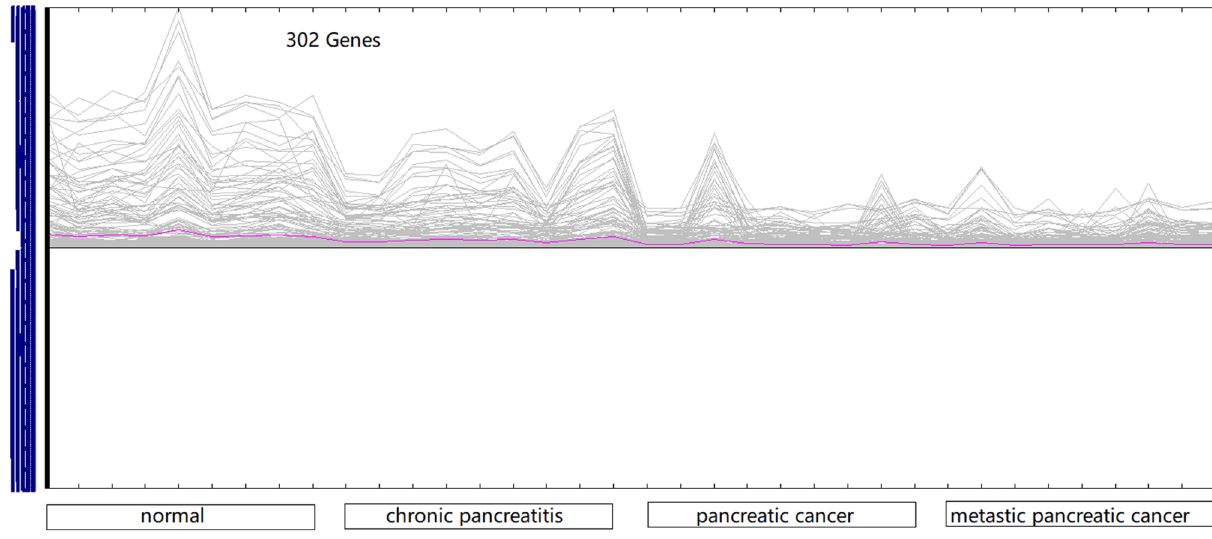
Figure 2. The expression graph of significant DEGs by Table S4); the metastatic pancreatic cancer DEGs were enriched in immune response, metabolism, energy path- way, protein metabolism and cell growth and maintenance (Fig. 3, Table S5). The SAM DEGs were enriched in lymphocyte activation, lymphocyte proliferation, protein metabolism, energy pathway and metabolism (Fig. 3, Table S6). The GO cellular component analysis of DEGs in all the pancreatic cancer progression was significantly enriched in extracellular matrix/region/space, exosomes, and plasma membrane (Fig. 4, Tables S3, S4, and S5). The SAM DEGs were enriched in ribosome, cytosol, etc. (Fig. 4, Table S6). The GO molecular function analysis of DEGs in all the pancreatic cancer progression was significantly enriched in extracellular matrix structural constituent, MHC class I receptor activity, and MHC class II receptor activity (Fig. 5, Tables S3, S4, and S5). The SAM DEGs were enriched in the structural constituent of ribosome and lipase activity (Fig. 5, Table S6). Site of expression analysis. The site of expression of DEGs in all the pancreatic cancer progression was significantly enriched in fluid and urine (Fig. 6, Tables S3, S4, and S5). The site of expression was further ana- lyzed in Fig. 6. We obtained the gene rankings based on the percentage of DEGs after FunRich software analysis and exported the top ten items. The output pictures were automatically ranked according to − log10 (P-value). Immune cells emerged in a multitude only in metastatic pancreatic cancer. The SAM DEGs were enriched in many immune cells, including CD4 T cells, CD8 T cells, monocyte, dendritic cells, B cell, etc. (Fig. 6, Table S6). Biological pathway analysis. The biological pathways of DEGs in all the stages of pancreatic cancer pro- gression were significantly enriched in epithelial-to-mesenchymal transition and integrin family cell surface interaction (Fig. 7, Tables S3, S4, and S5). The DEGs of chronic pancreatitis were enriched in integrin family cell surface interaction (beta1, beta2, beta3) (Fig. 7, Table S3). The DEGs of pancreatic cancer were enriched in translational elongation and termination to support new protein synthesis (Fig. 7, Table S4). The SAM DEGs were enriched in all the levels of gene expression regulation, including mRNA, protein, etc. (Fig. 7, Table S6). Weighted gene co-expression network analysis. After network construction, 19 gene co-expression modules were identified. The number of genes in the modules varies between 47 and 1233 (N = 9,046, 758 genes were “gray” genes, not assigned to a module) (Table S7). We selected the best soft-thresholding β = 6 to ensure a scale-free network. Other details of the WGCNA analysis were reported in the supplement (Supplementary Figs. S1, S2, S3 and S4). We selected modules significant for association with the pancreatic pathological process and performed further analysis (Fig. 8). In the module-trait relationship obtained, several modules got raising correlation coef- ficients from the normal state to metastatic pancreatic cancer (Fig. 8a). The correlation coefficients of these modules vary from negative to positive. They are red, salmon, tan, and black modules. GO biological process analysis shows genes in the red module most enriched in T-cell activation, in lipopolysaccharide and interferon in the salmon module, in protein process and gene silencing in the black module, in vesicle and synaptic process in the tan module (Table S8). We took red, salmon, tan, and black modules to further analysis, and it is worth noticing that genes of the red module have been enriched in immune response, similar to the previous GO bio- logical processes analysis of the DEGs of chronic pancreatitis, pancreatic cancer, and metastatic pancreatic cancer. The top20 genes in salmon and red modules significantly overlap with DEGs. The correlation between each gene in a module and the module eigengene defined the eigengene-based connectivity. Since genes with high eigengene-based connectivity can be inferred as playing important roles in this module, we select respectively the